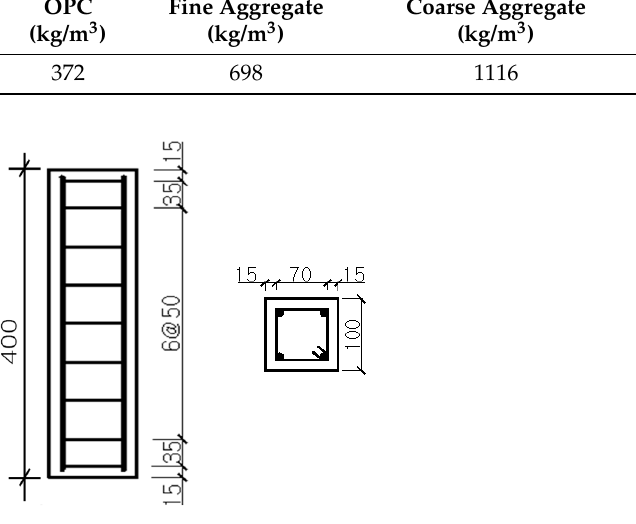
Figure 1. Reinforcement configuration (units mm).